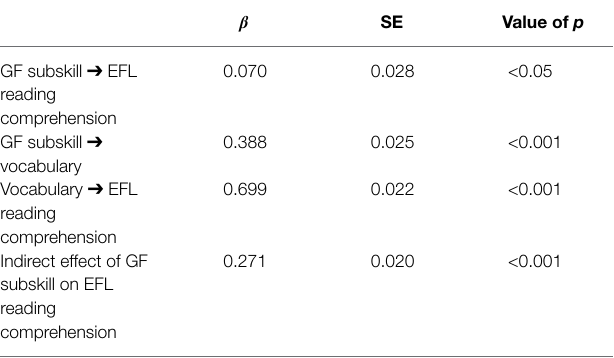
TABLE 6 | Mediation effect of vocabulary in the GF